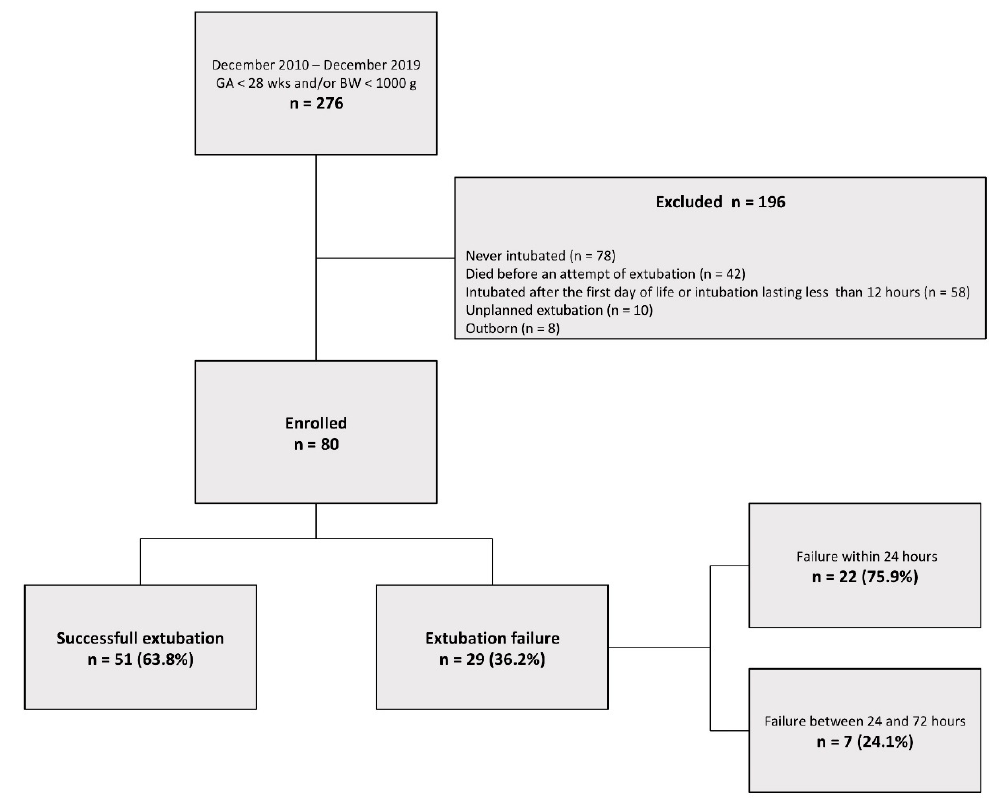
Figure 1. Flow chart of study population selection.